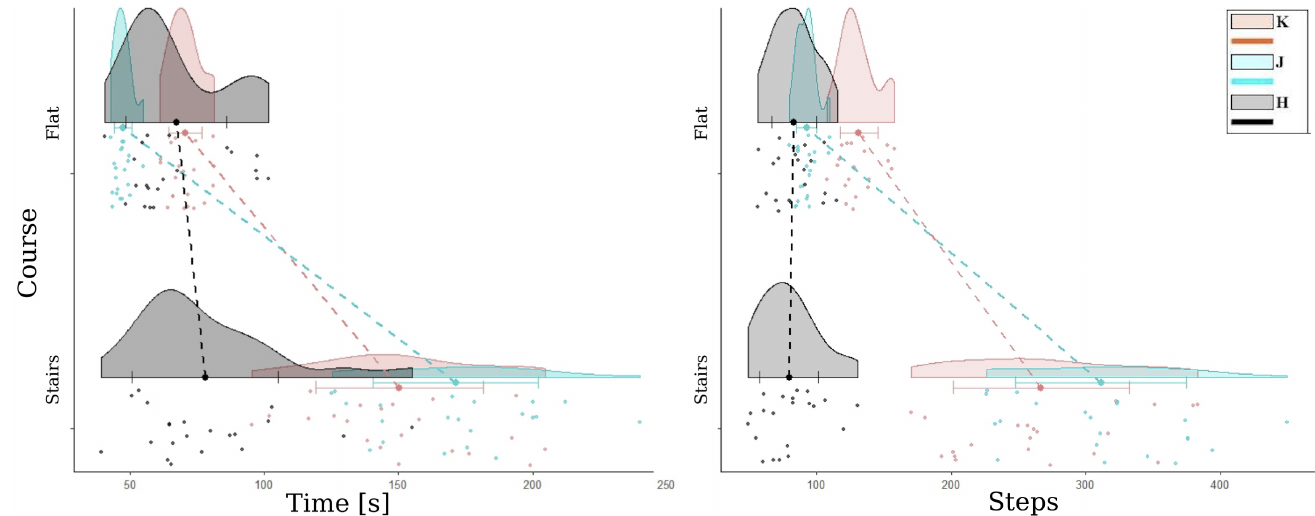
Figure 13. Performance robustness to increased task complexity. Left plot shows performance shift in time to completion, right shows performance shift for number of steps. Pink indicates K , blue indicates J , gray indicates H . Table 2. Tukey-Honest Significant Difference (HSD Corrected Pairwise Comparisons, Experiment